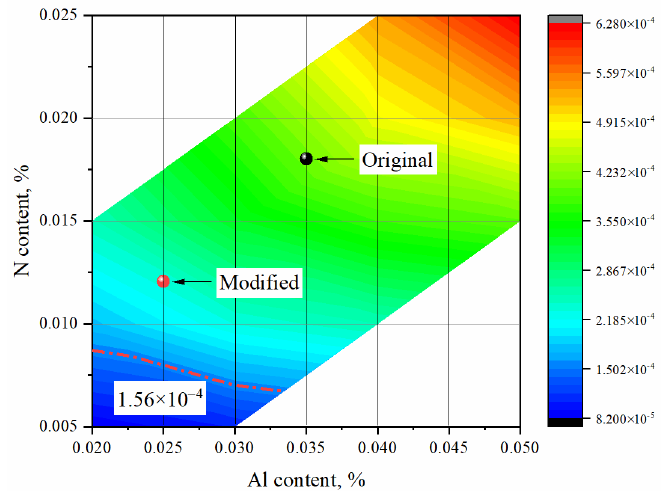
Figure 14. Calculated mass fraction of AlN precipitation at 960 °C with the variations of Al and N